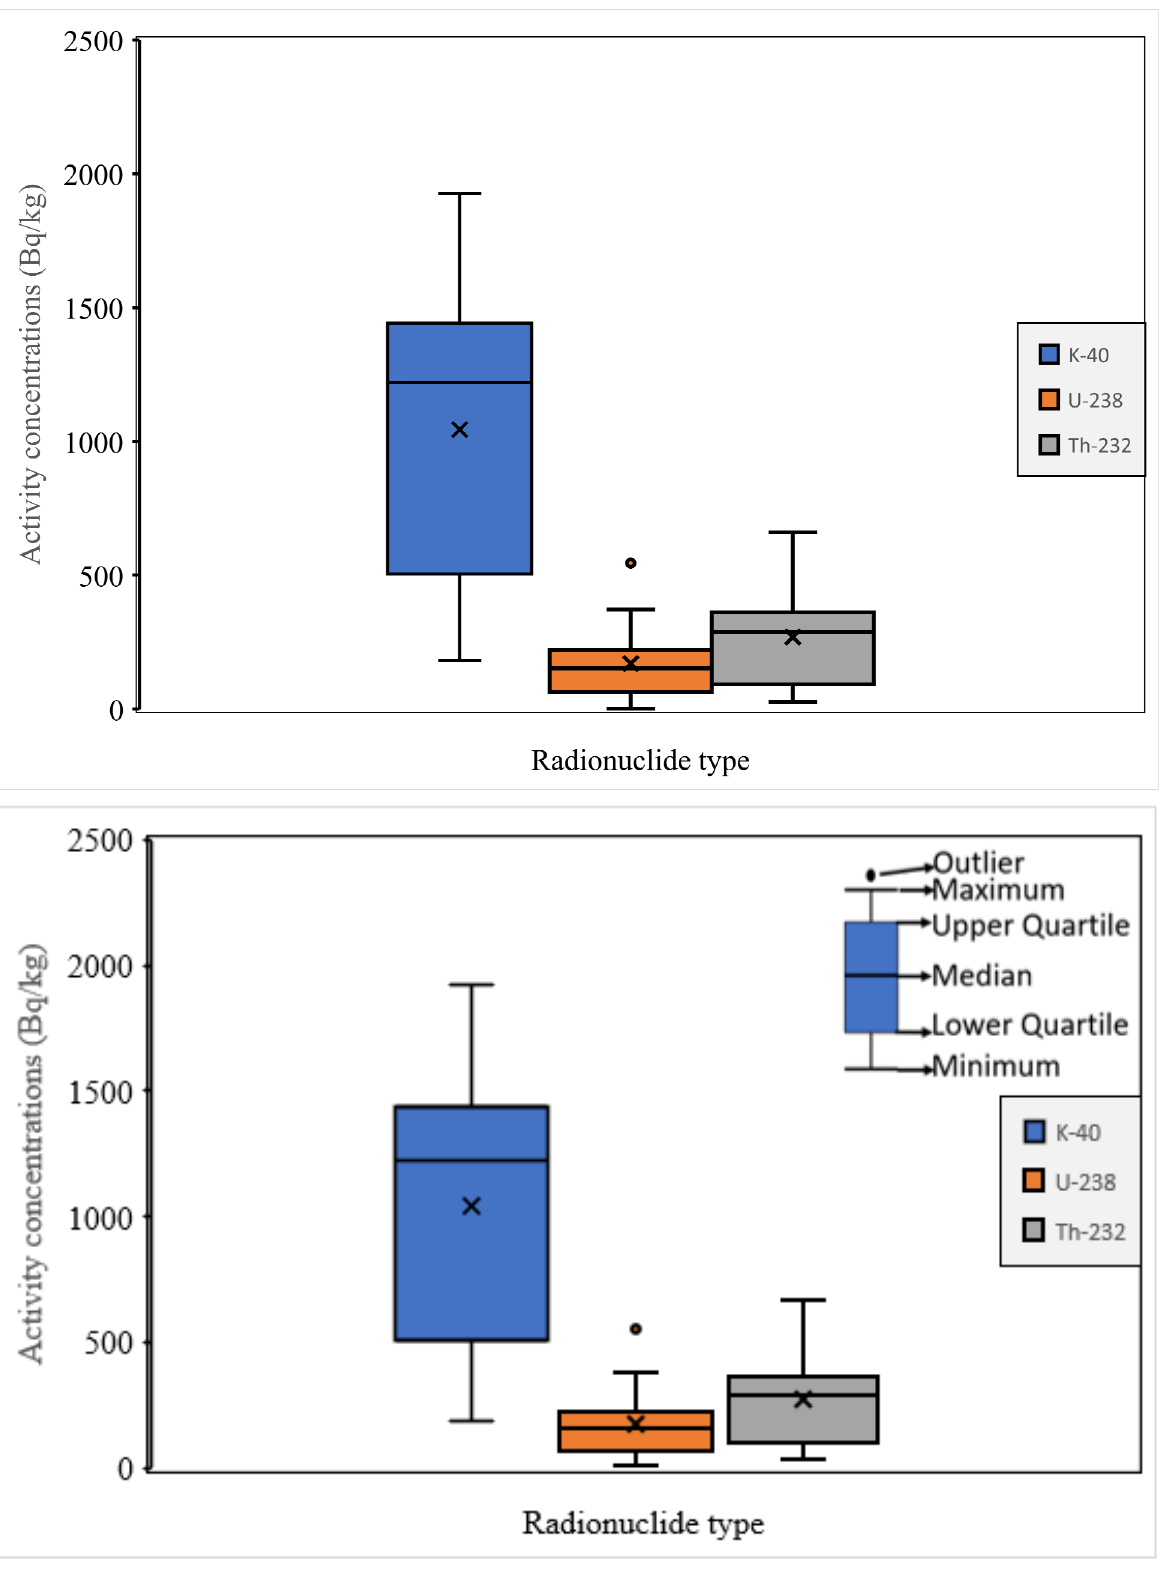
Figure 3. Basic statistics of the distribution of radionuclides in the rocks